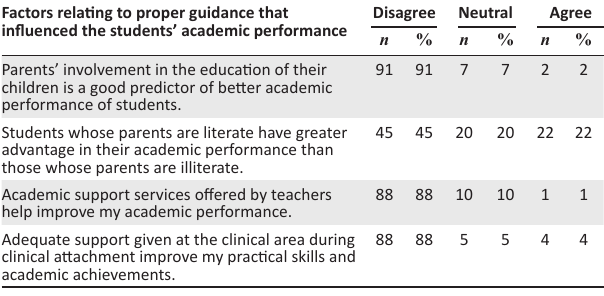
TABLE 2: Student nurses’ perceptions of factors relating to learning facilities that influenced their academic performance.